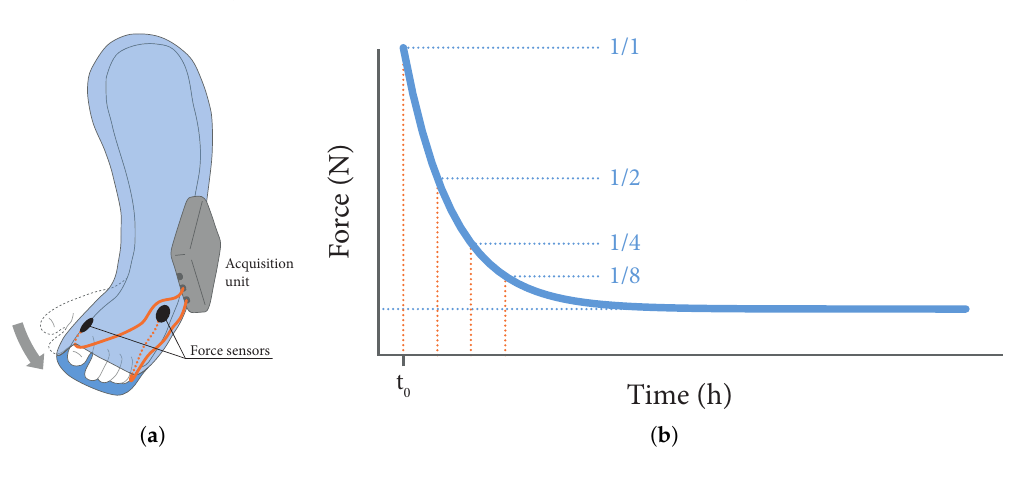
Figure 1. ( a ) Sensor location: The clubfoot is fixated in a corrected position with a plaster cast. ( b ) Expected plot: Initially the foot presses against the cast but over time this force decreases due to adaptation of the biological tissues. Table 1. Sensor requirements. A small Lipo battery (165 mAh) should be able to power the system for at least one week (168 h), hence the set requirement for the maximum power